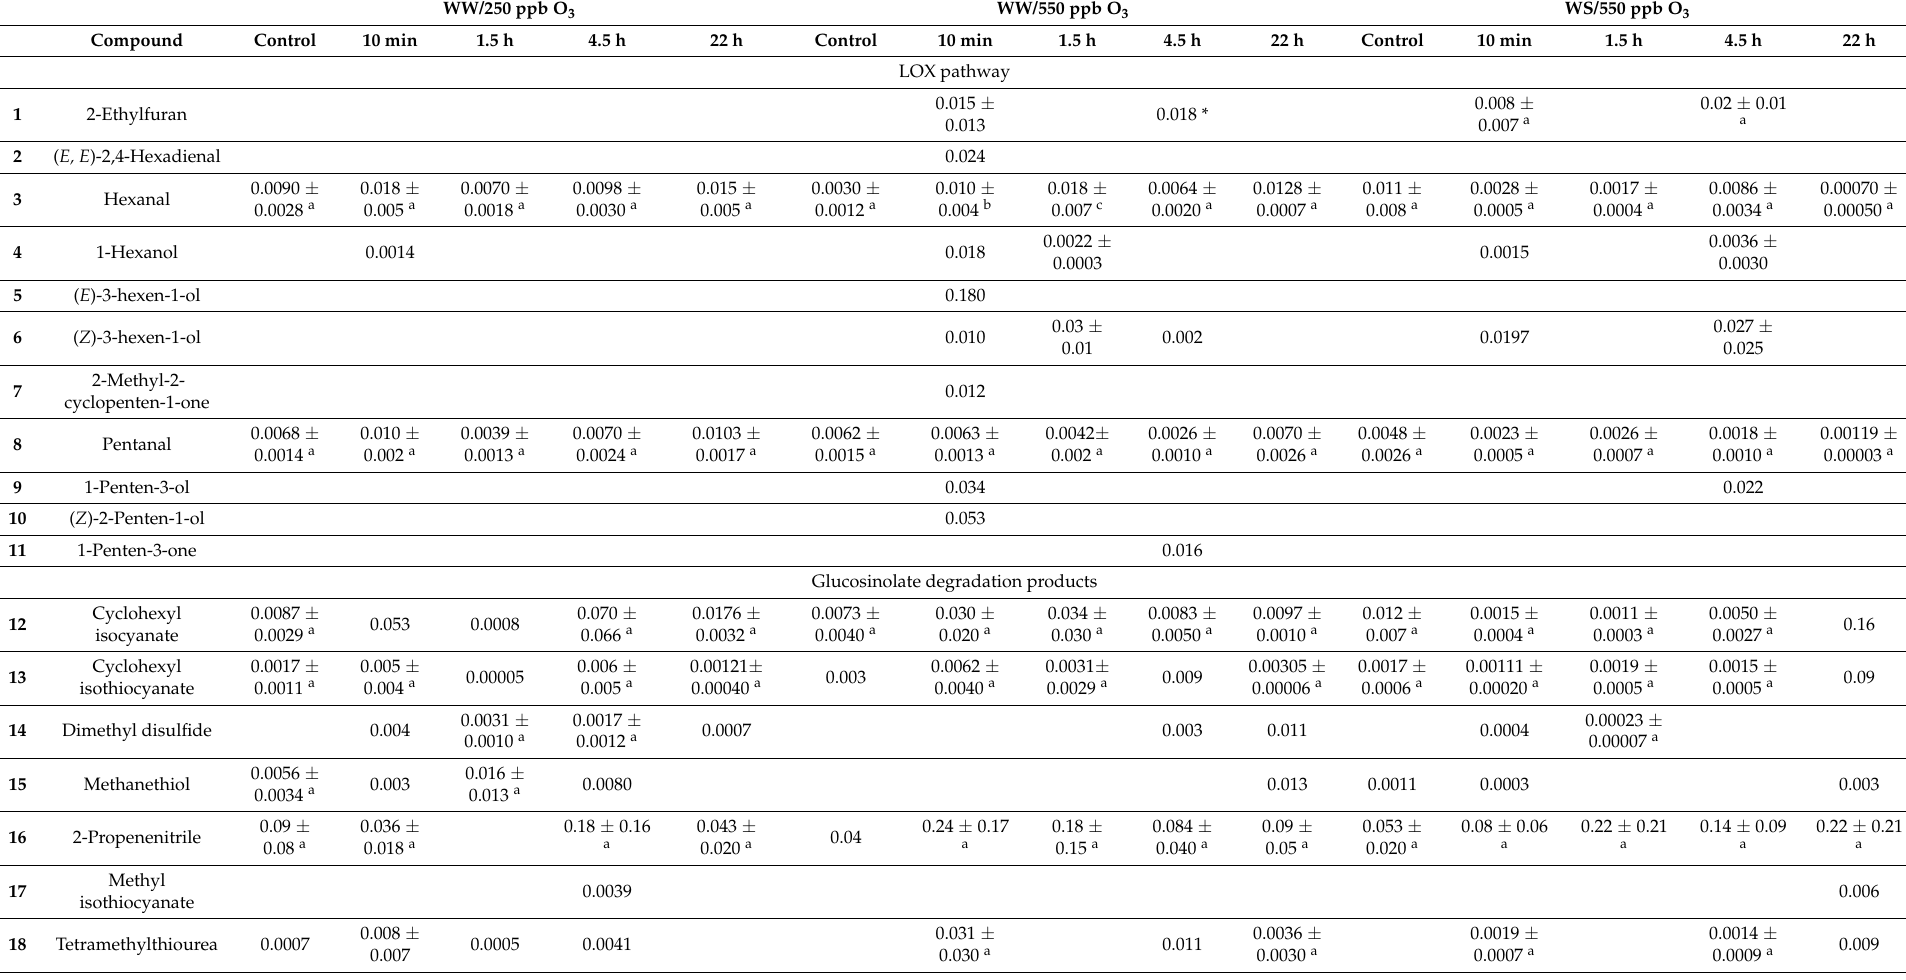
Table 2. Average ( ± SE) emission rates of individual volatile organic compounds detected in the emissions of well-watered (WW) and water-stressed control and O 3 -treated (250 ppb or 550 ppb O 3 for 1 h) Brassica nigra